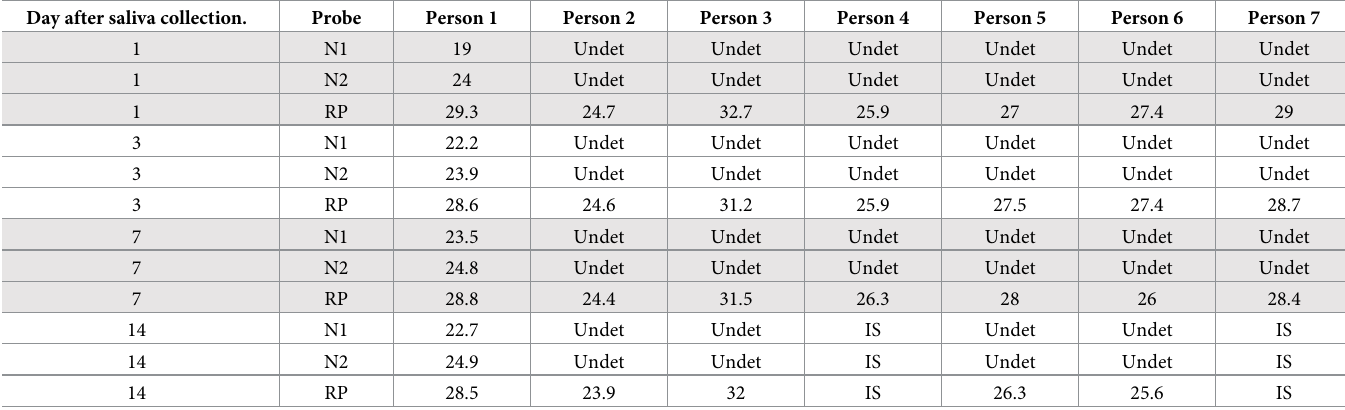
Undet: not amplified. IS: insufficient sample to perform the